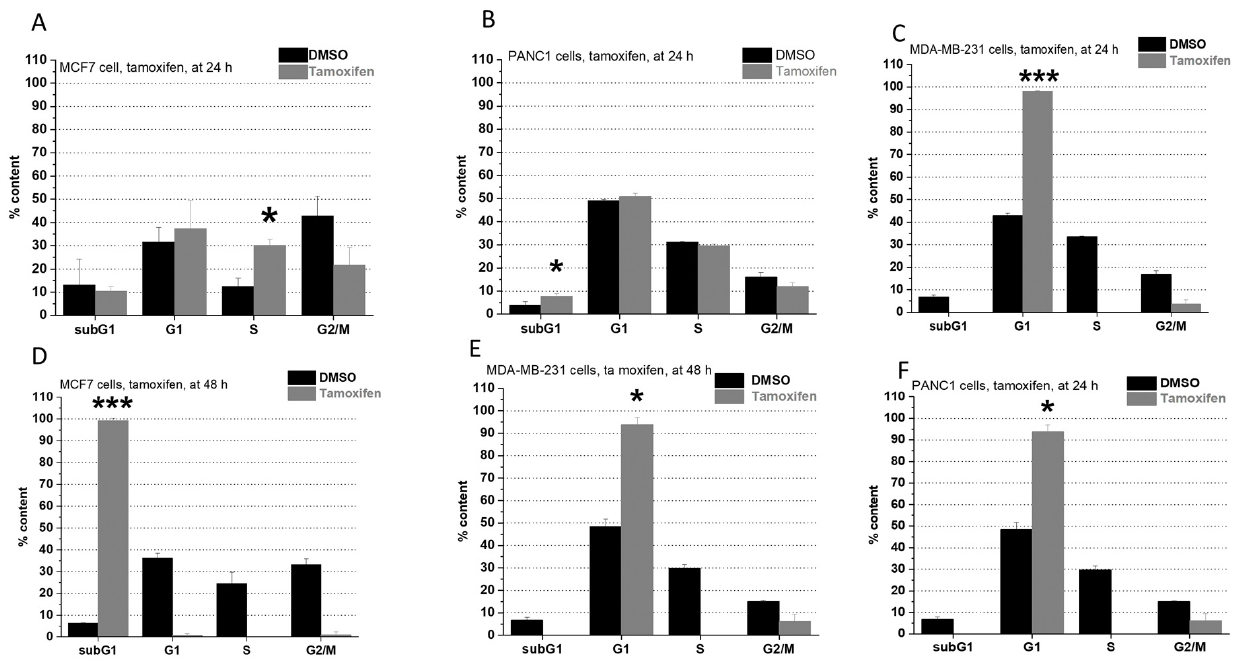
Figure 1. Impact of tamoxifen on the cell cycle on MCF7 (( A ): at 24 h, ( D ): at 48 h), MDA-MB-231 (( C ): at 24 h, ( E ): at 48 h), and PANC1 cells (( B ): at 24 h, ( F ): at 48 h). Each cell line was treated with 25 µM. Each result represents the measurement of two parallel samples ( n = 2). Data are given as mean values ± standard deviation (SD). Asterisks mark the subpopulation, where the number of cells is significantly higher compared to the DMSO control, and a cell cycle arrest is seen ( p < 0.05: *, , p < 0.001: ***) determined by the One-way ANOVA test followed by Fisher’s LSD post hoc test.